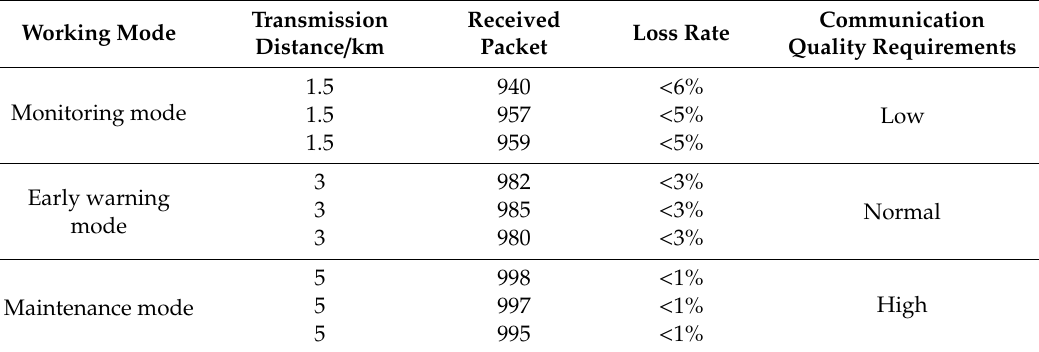
Table 4. Communication test results of three working modes of the system.